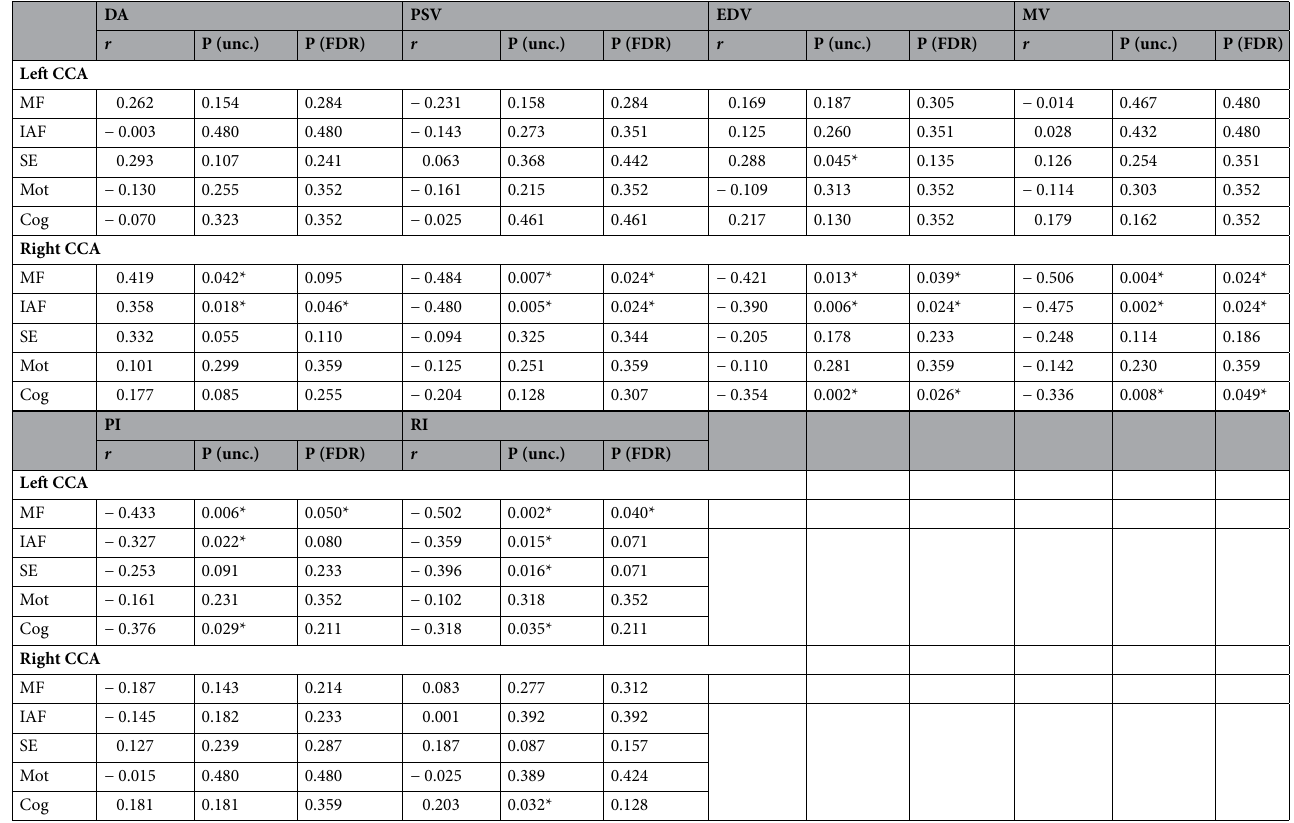
Table 2. Correlation matrix between sided ultrasonographic parameters, MEG spectral parameters, and FIM. CCA common carotid arteries, Cog . cognitive-FIM score, FIM functional independent measurement,